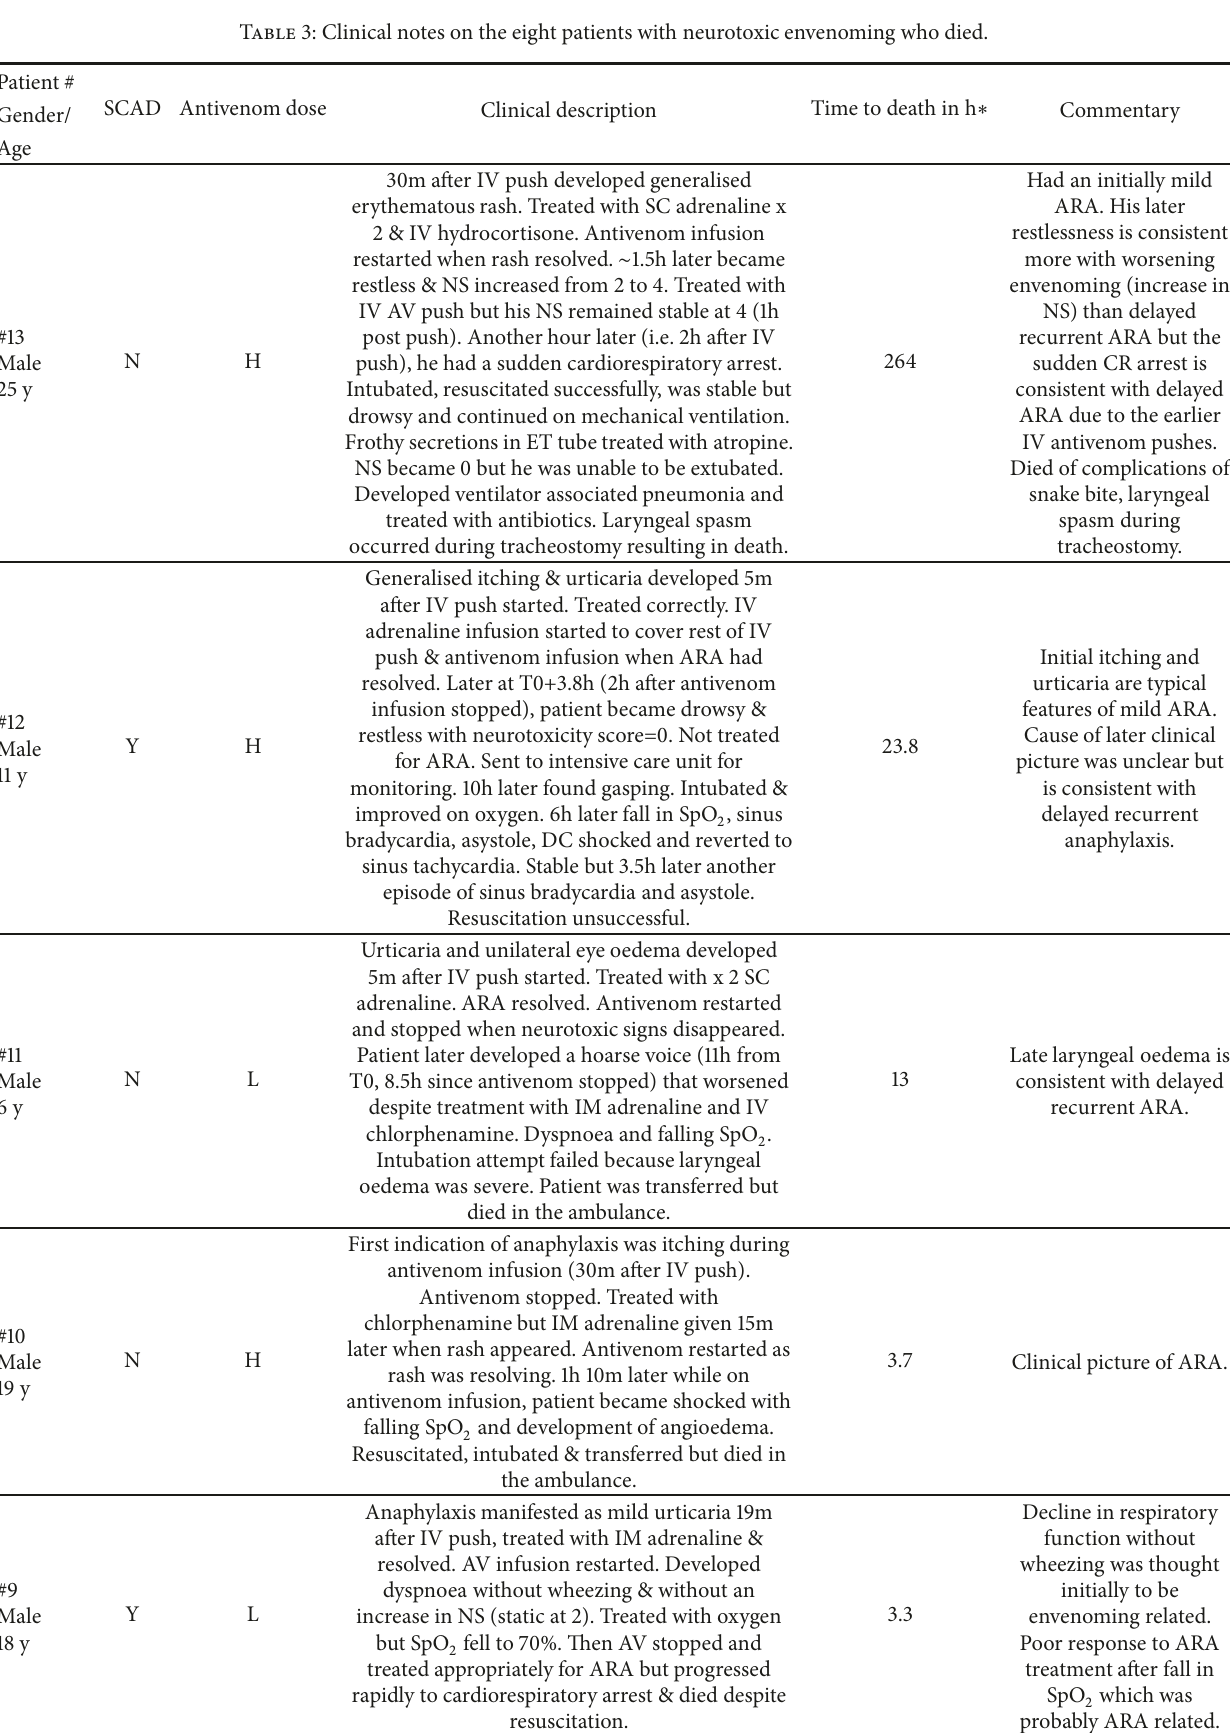
Table 3: Clinical notes on the eight patients with neurotoxic envenoming who died. Patient